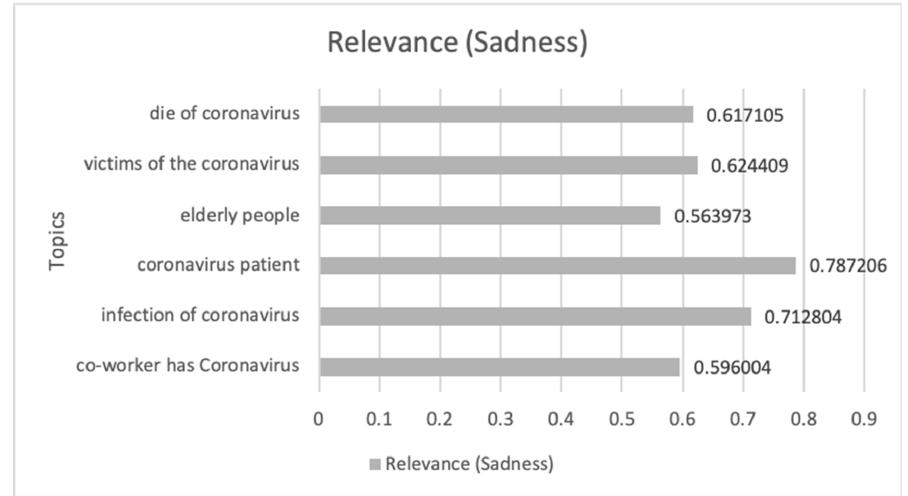
Figure 7. The themes related to COVID-19 and Disgust emotion that have impacted most along with its impact value.